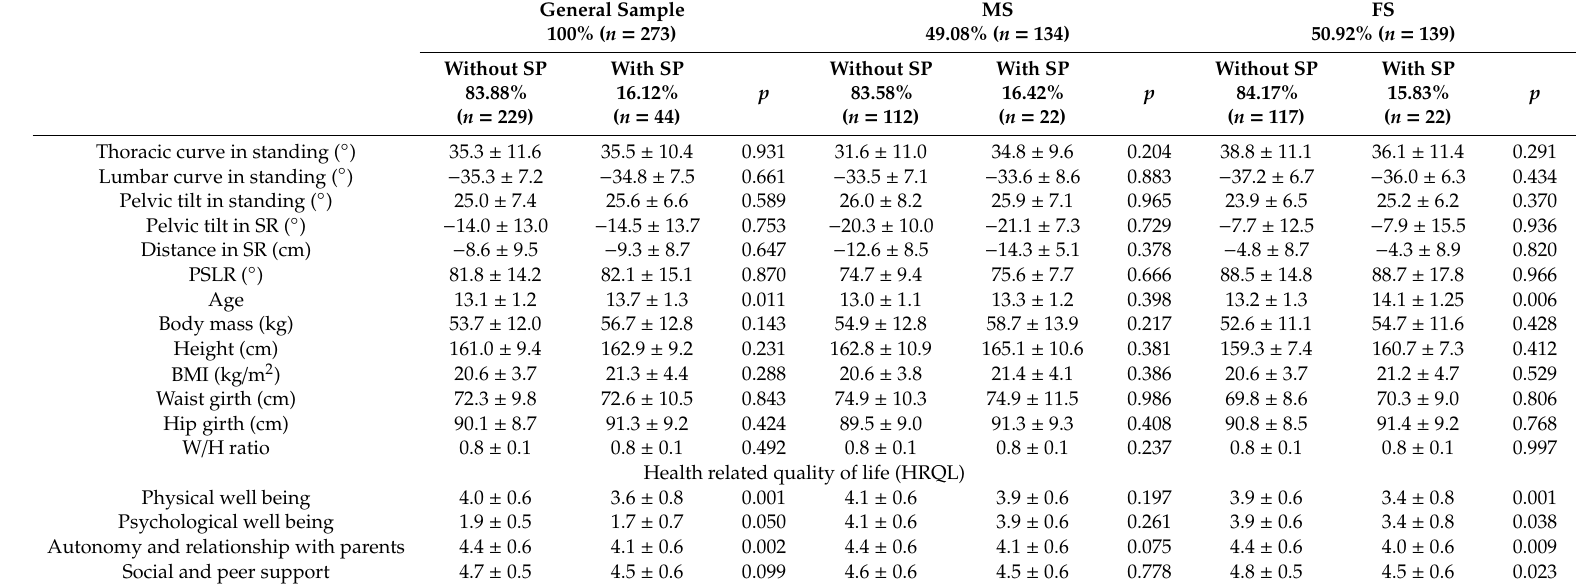
Table 3. Mean values ( ± SD) of curvatures, anthropometric variables and HRQL and di ff erences between SP and